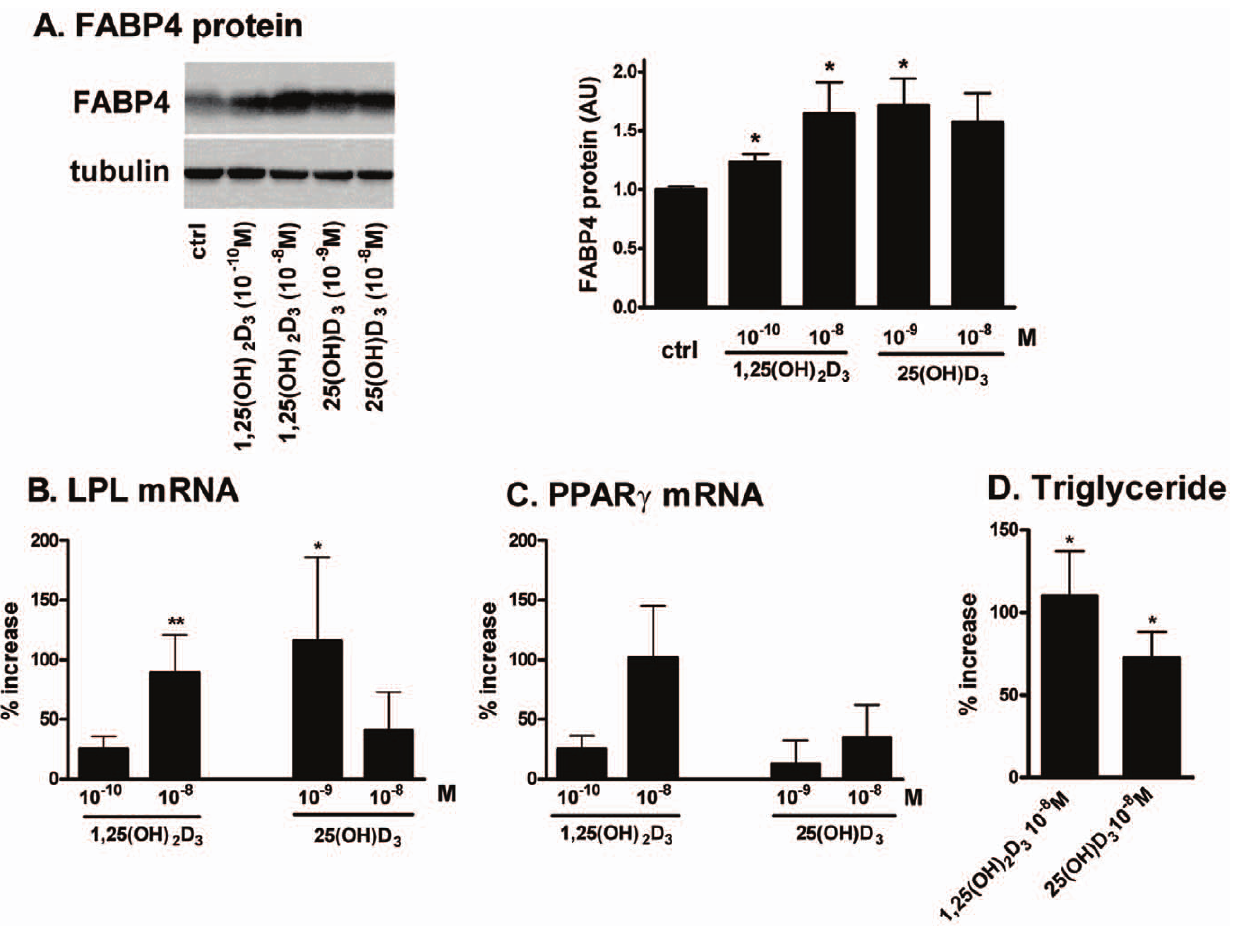
Figure 3. 25(OH)D 3 and 1,25(OH) 2 D 3 promoted the differentiation of human preadipocytes. Human preadipocytes were differentiated in the presence of vehicle control, 1,25(OH) 2 D 3 (10 2 10 , 10 2 8 M) or 25(OH)D 3 (10 2 9 , 10 2 8 M) and expression levels of adipogenic markers were measured on d14. A. Representative immunoblots of FABP4 protein (left panel) and quantification (right panel) are shown (n=6). Expression levels of LPL (B; n=7) and PPAR c mRNA (C; n=6) and TG accumulation (D; n=4) were presented as % increase over vehicle control. *, p , 0.05, **, p , 0.01, vehicle control vs. treatments.